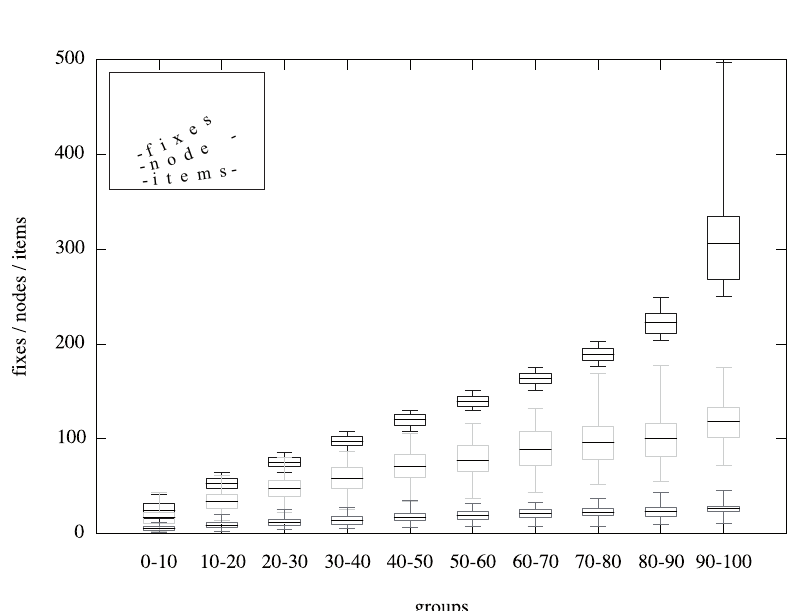
Figure 7: Results for synthetic trajectories. Shown are the number of fi xes in the original trajectory, nodes in the corresponding path, items in the compressed trajectory. Trajectories have been divided into ten length classes according to the number of fi xes (lowest 10%, 10–20%, ...). The box-whisker plot displays the minimum and maximum of a group (the T- ends of the lines), the interquartile range (the boxes), and the mean number (the horizontal lines in the